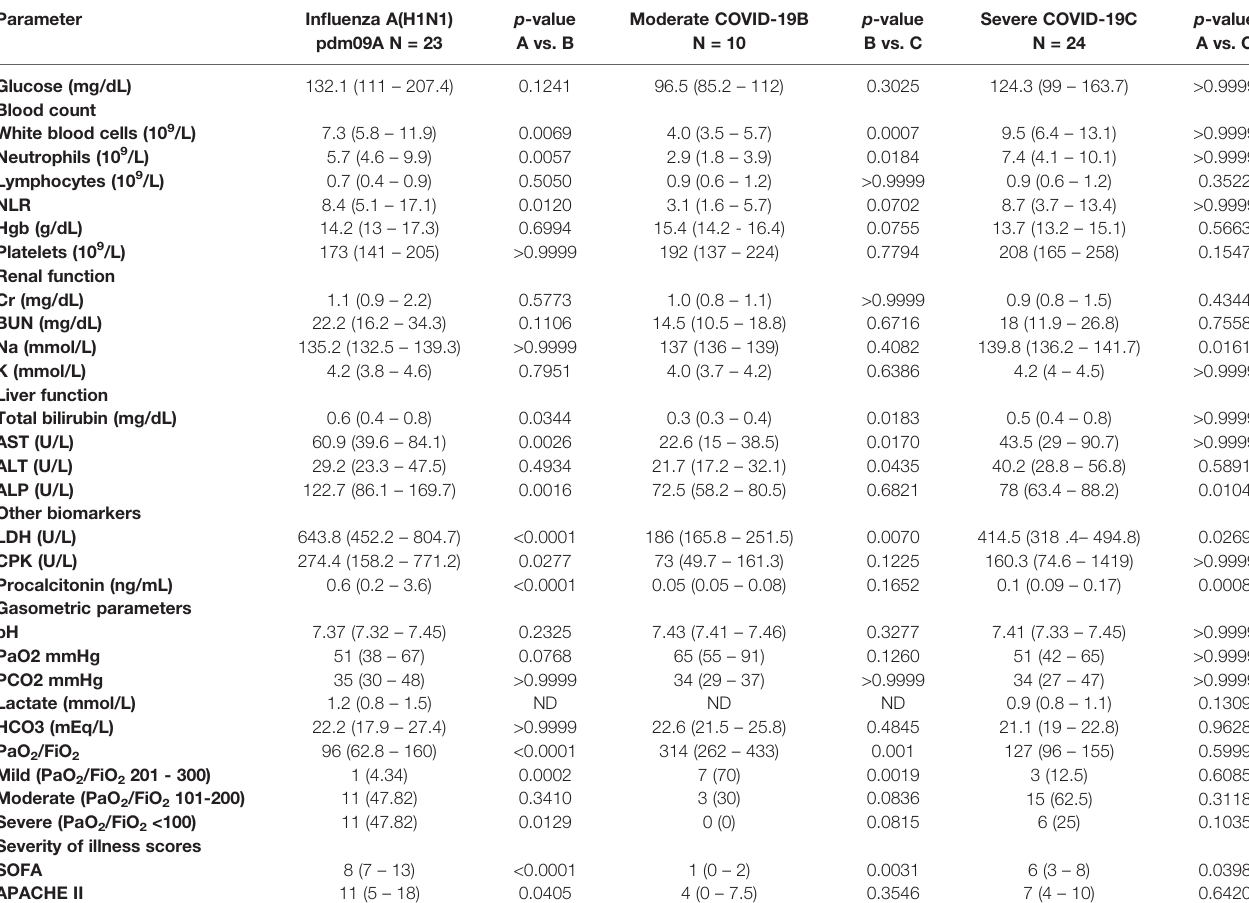
TABLE 2 | Laboratory parameters of participants at